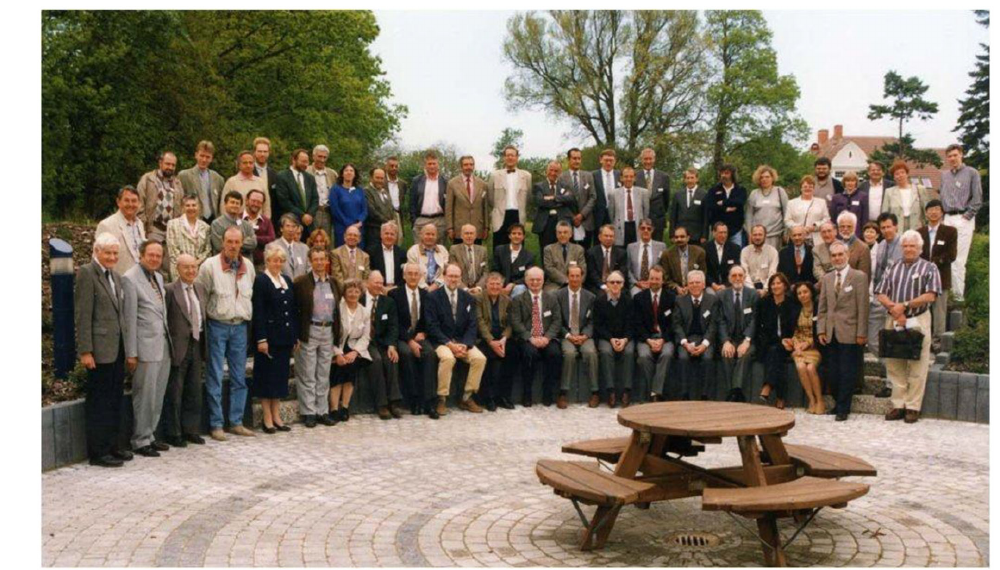
Figure 10. Group photo of participants at the joint IRI-COST 251 meeting held at the Institute of Atmospheric Physics of Kühlungsborn, Germany, in May 1997. Henry Rishbeth, Peter Antony Bradley, and Karl Rawer are respectively the first, second, and eighth from the left in the first